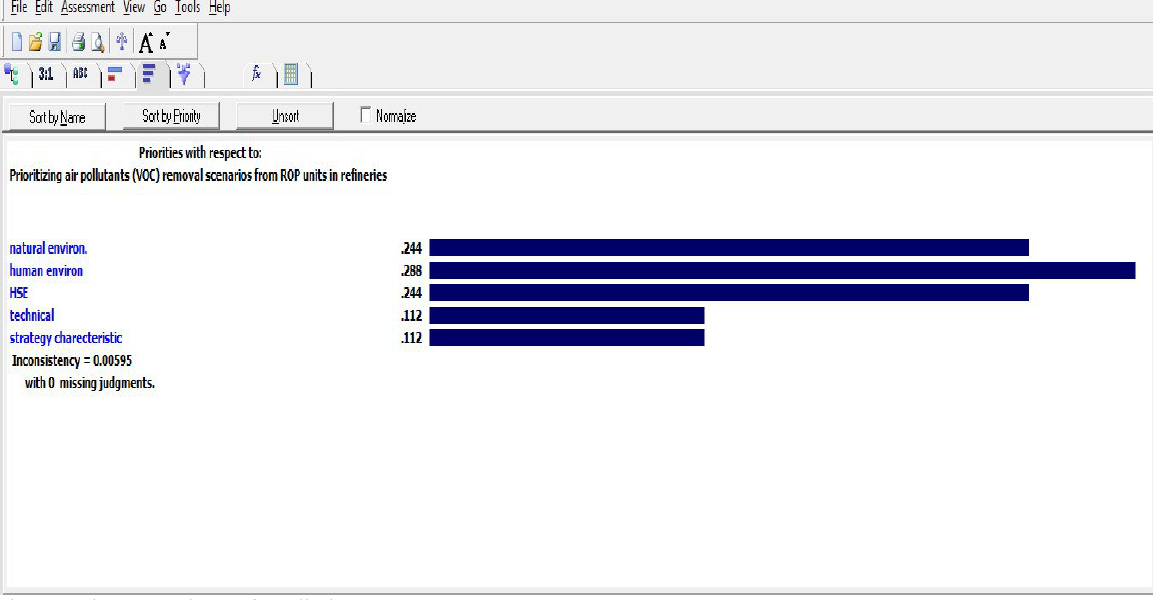
Fig. 3. Pair comparison of studied